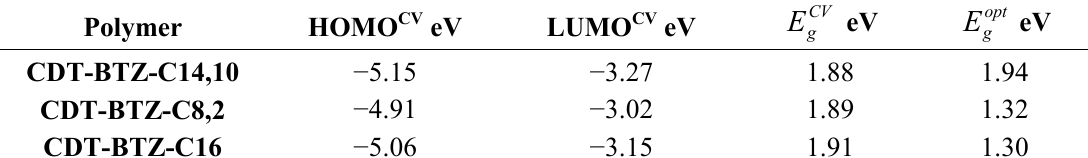
Table 1. Electrochemical derived highest occupied molecular orbital (HOMO) and the lowest unoccupied molecular orbital (LUMO) energy levels and energy gaps of CDT–BTZ polymers with different side